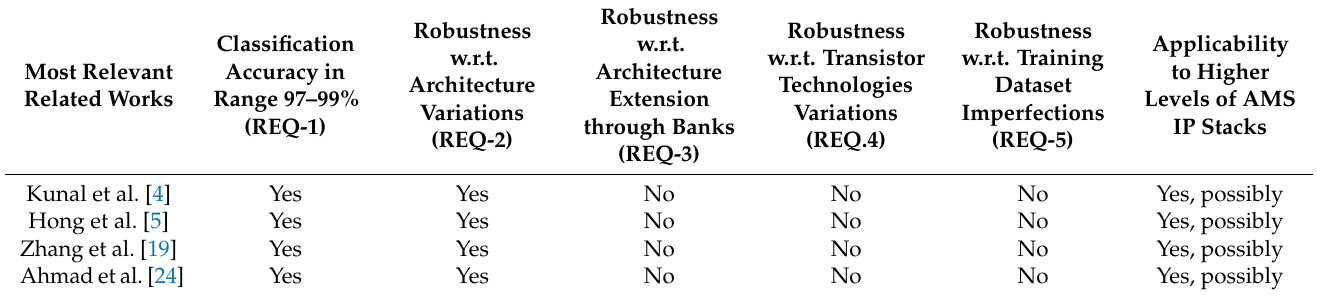
Table 1. An overview of the most relevant related works w.r.t. an assessment of how far they do satisfy the six requirements formulated and outlined in Section 2 (see Requirements Engineering